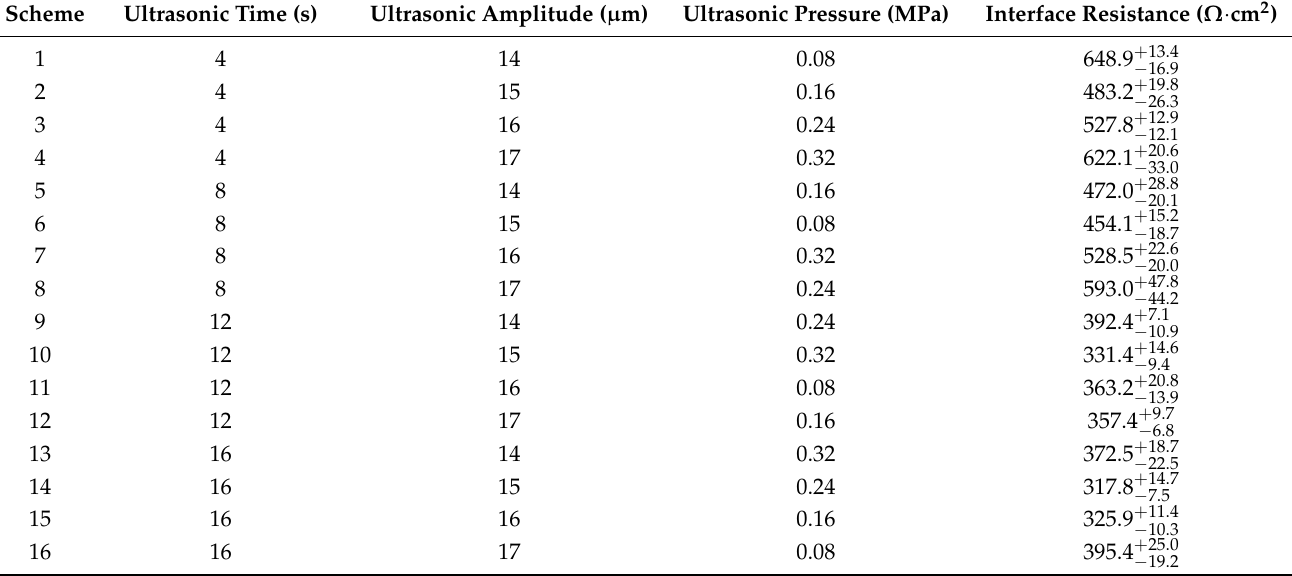
Table 1. Orthogonal schemes and experimental